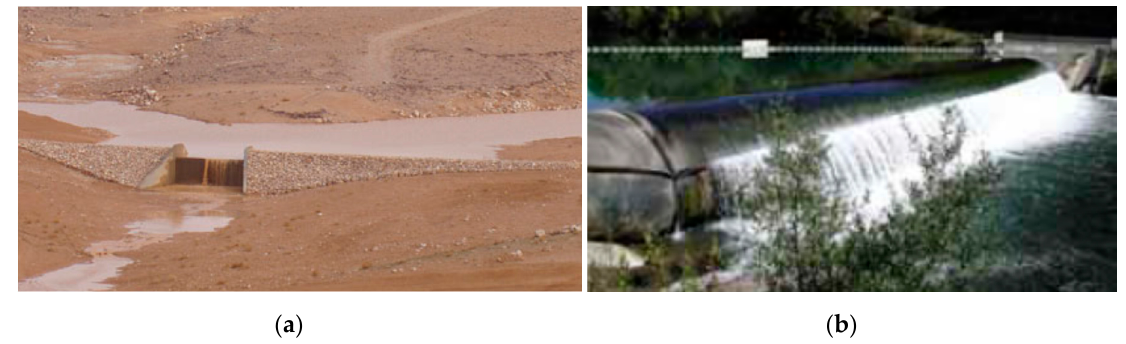
Figure 3. ( a ) Wadi-recharge dam, Jordan, reproduced with permission from de Laat and Nonner, Environmental Earth Sciences, published by Springer Nature (2011); and ( b ) Rubber dam, Russian River, USA, reproduced with permission from US Geological Survey (2008).